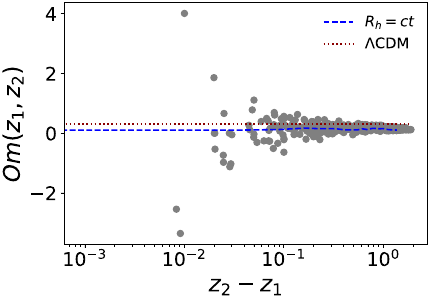
Fig. 2 Plot of Om ( z 1 , z 2 ) calculated from the chronometer data using Eq.8.Thesepointswerecalculatedfromcombinationsofthe31Hubble measurements in pairs, amounting to 465 points. The theoretical plots are not included because the theoretical curves cannot be distinguished at this scale weighted mean of all the Om ( z 1 , z 2 ) measurements. For R h = ct , the only free parameter would be H 0 , since varying H 0 would vertically re-scale the whole plot by a constant offset.